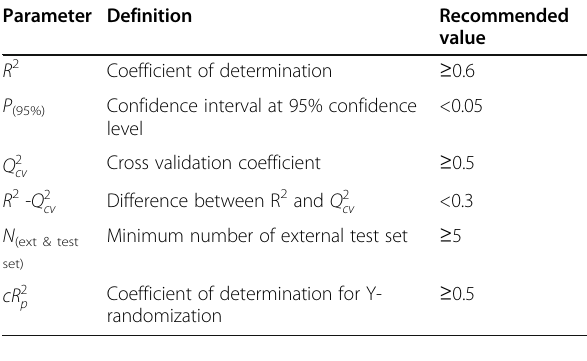
Table 2 Generally recommended values for the validation parameters for a built model